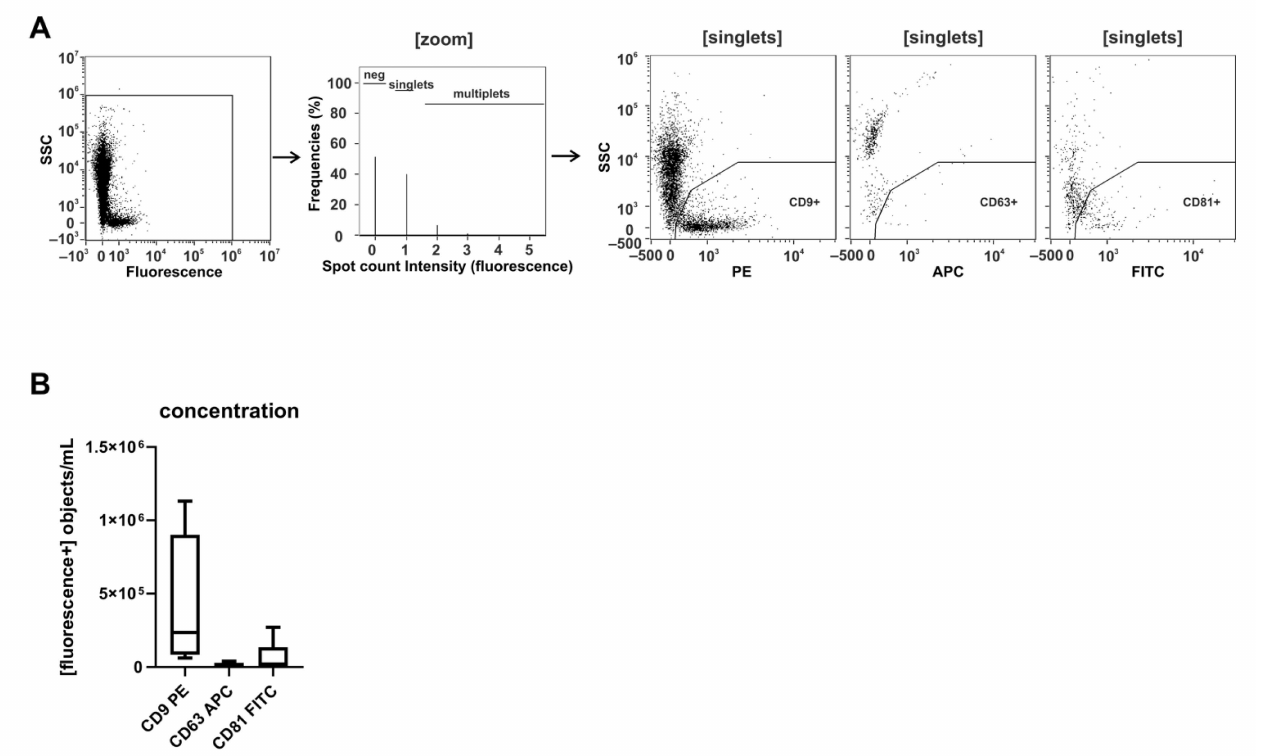
Figure 1. CD9 is abundantly present on small urinary EVs of healthy donors. Freshly pre-processed void urine samples (n = 4) were stained with anti-CD9, anti-CD63, and anti-CD81 antibodies. After a 1-hour incubation step, samples were analyzed using imaging flow cytometry (IFCM). ( A ) Applied gating strategy: from all recorded signals (first plot), data points lacking any spot count signal or showing coincidences were neglected (second plot). Side scatter intensities of single objects are plotted against the fluorescence intensities of CD9-, CD63-, and CD81-labeled objects. ( B ) Box plots reflecting the numbers of recorded CD9 + , CD63 +, and CD81 + objects from the different